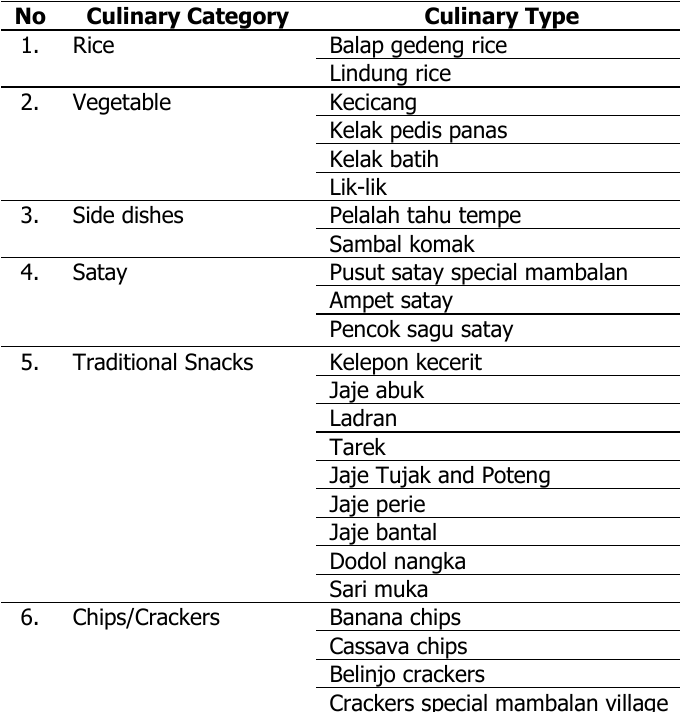
Table 2. Qualitative Analysis of Local Culinary